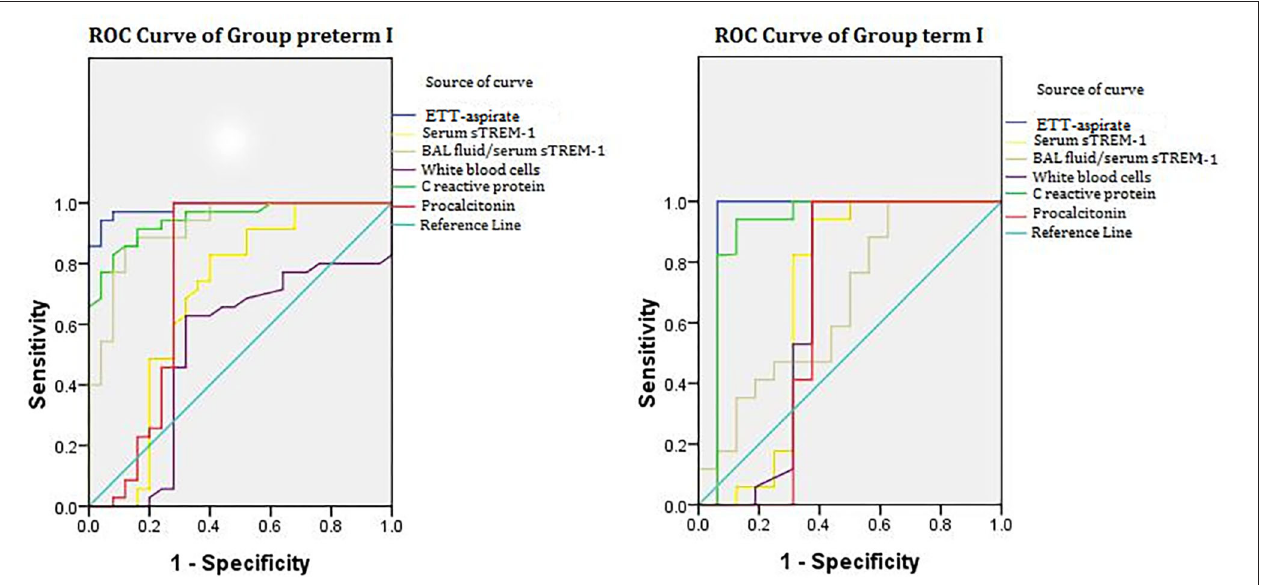
for group ptP + E– ( P < 0.05). The AUC of white blood cell count was not statistically significant for either group ( P >